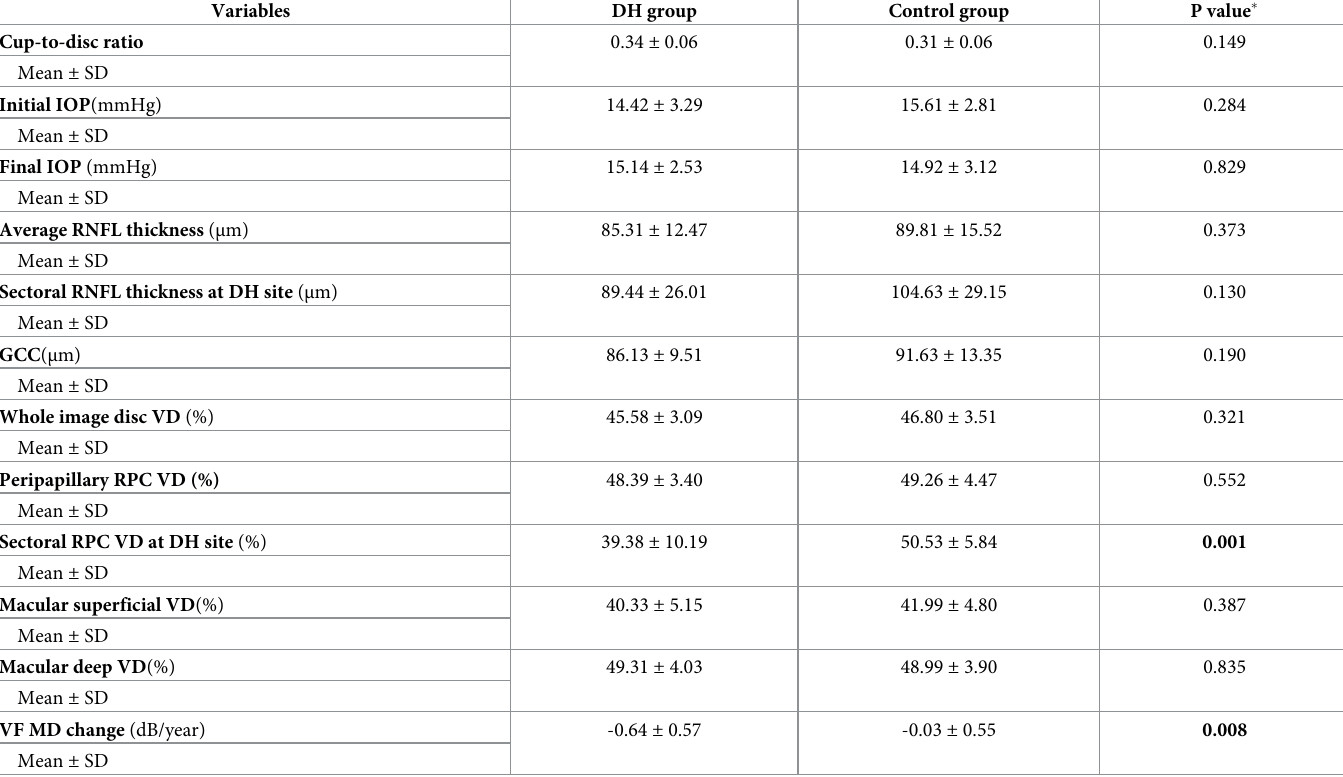
Table 2. Comparison of structural and functional parameters of nonglaucomatous disc hemorrhages with the fellow eyes.